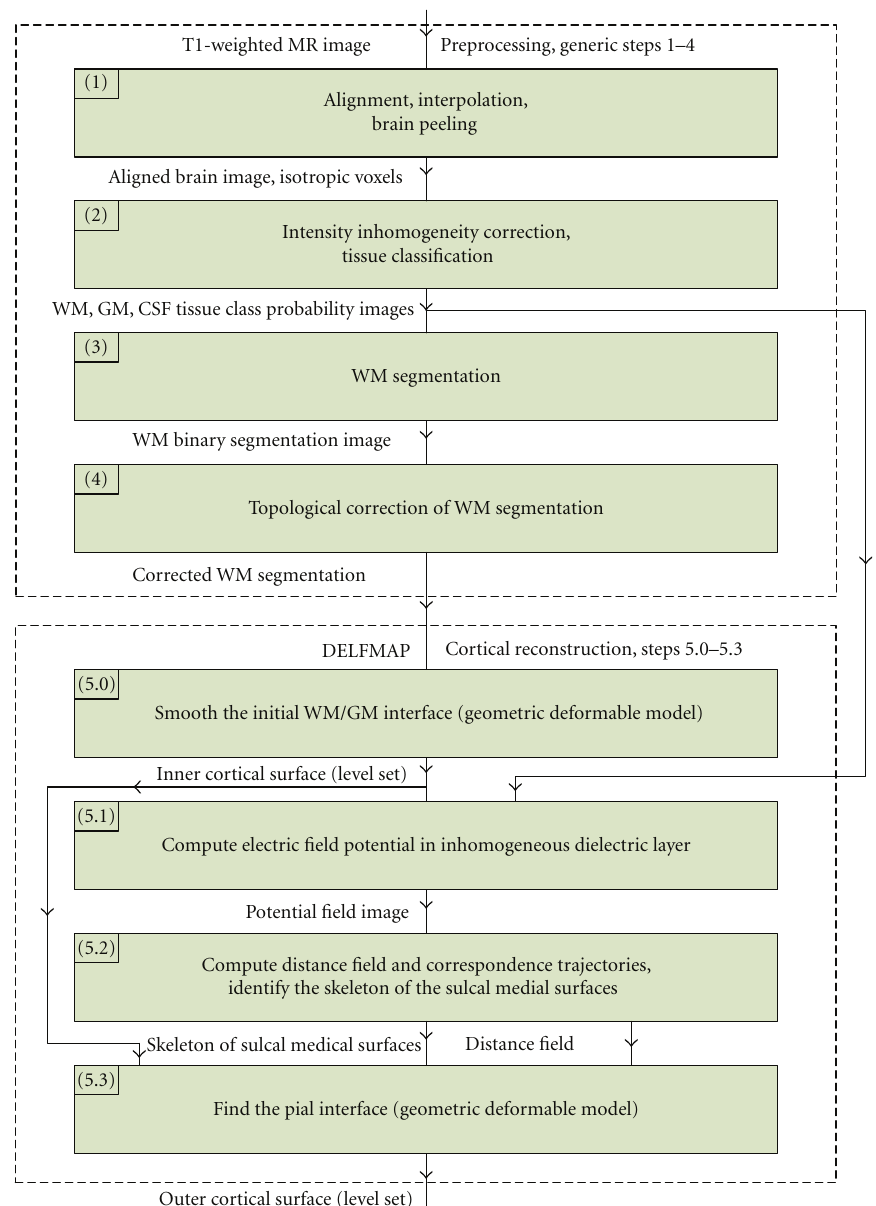
Figure 2: Block diagram of the overall image processing chain, where the DELFMAP method addresses the reconstruction of cortical surfaces (steps 5.0–5.3) after the preprocessing stage (steps